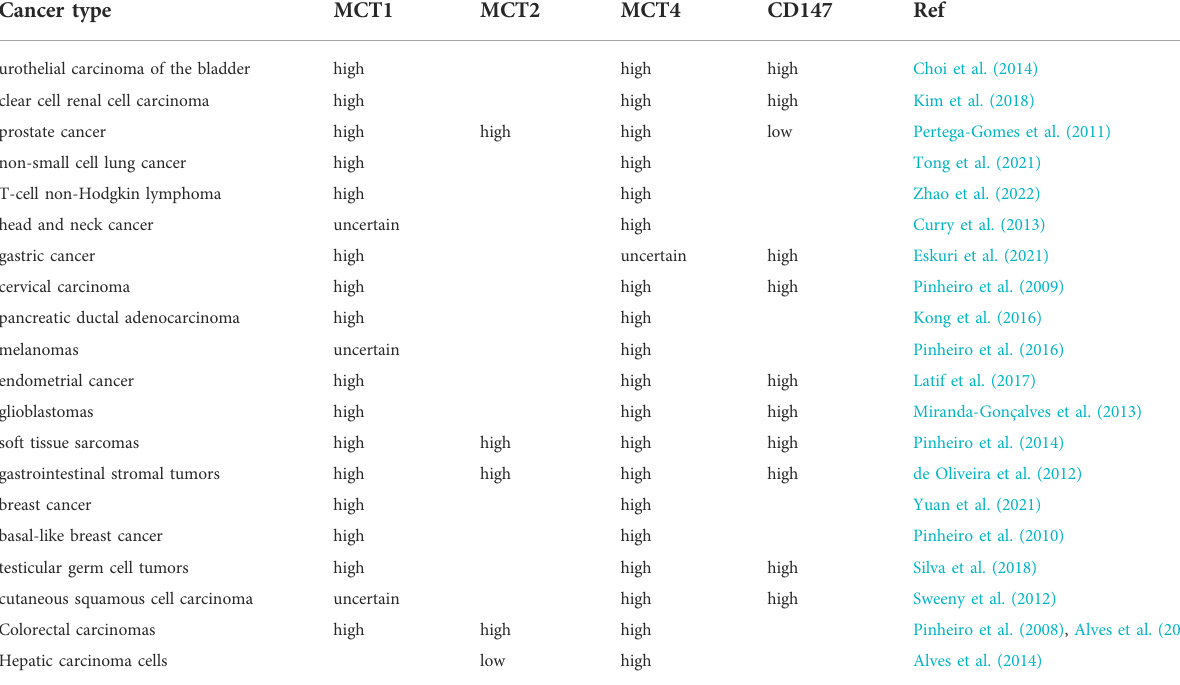
TABLE 1 Changes of MCTs expression in human cancers comparing with normal tissues.